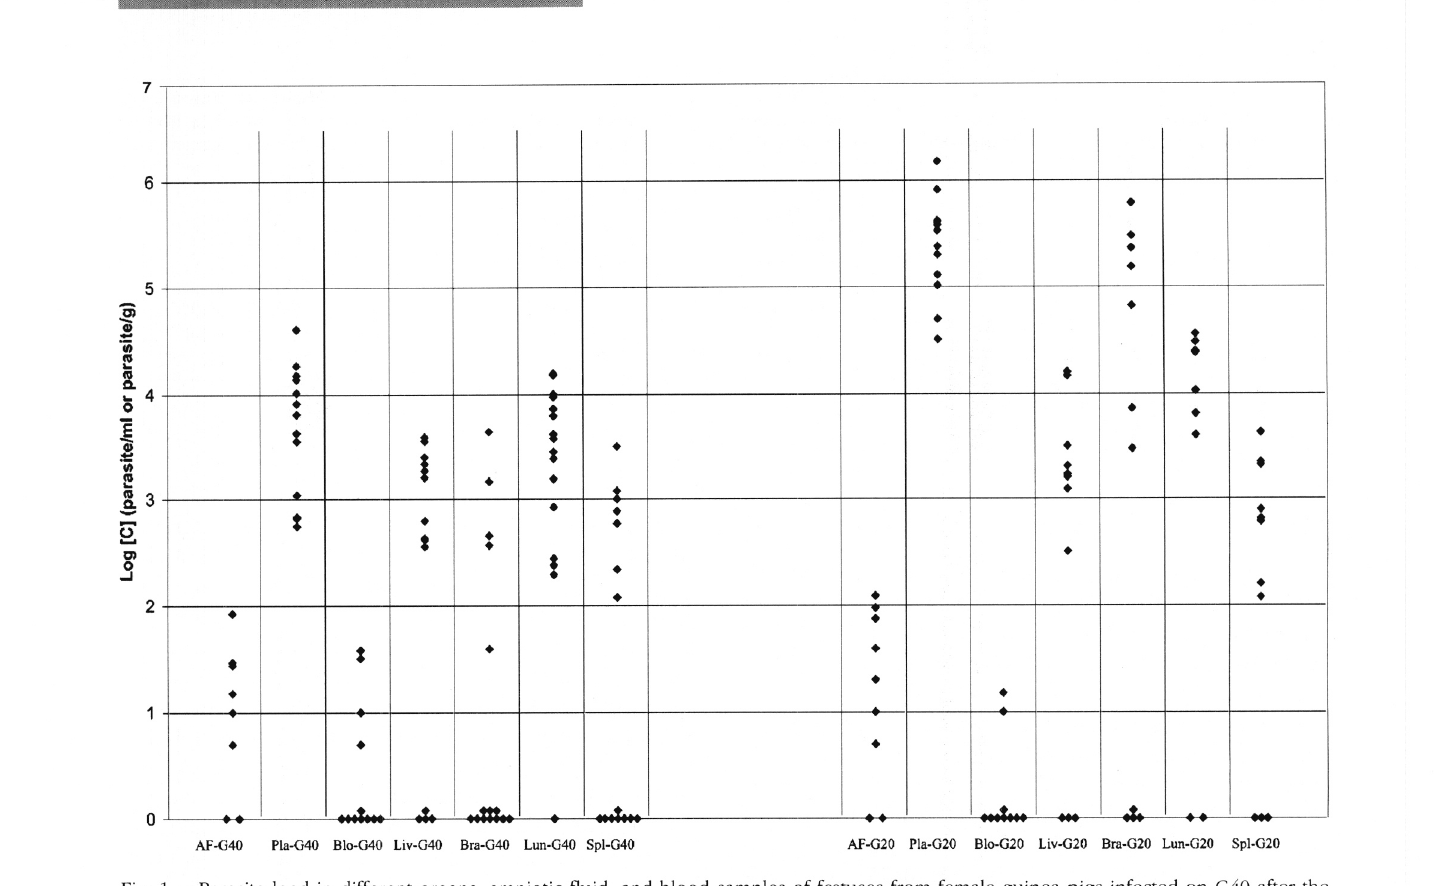
Fig. 1. - Parasite load in different organs, amniotic fluid, and blood samples of foetuses from female guinea pigs infected on G40 after the beginning of gestation (i.e. 20 days before the sampling of tissue on day G60) and on G20 after the beginning of gestation (i.e. 40 days before the sampling of tissue on day G60). AF: amniotic fluid; Pla: placenta; Blo: blood samples; Liv: liver; Bra: brain; Lun: lung; Spl: spleen. G40: maternal inoculation on day 40 after the beginning of gestation. G20: maternal inoculation on day 20 after the beginning of